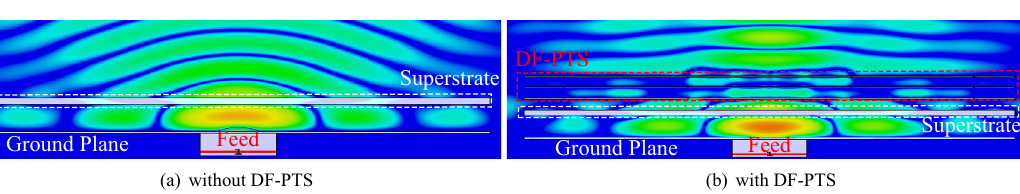
Figure 13. Snapshot of the near field distribution (dominant E y field component) in a cross-section of the antenna.